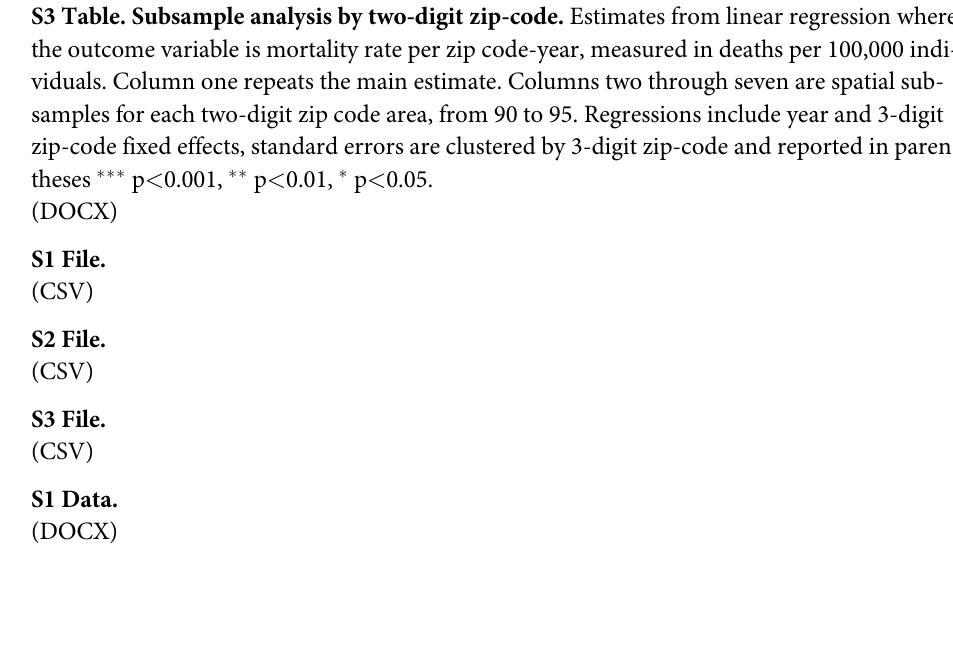
S1 Table. Summary statistics for sociodemographics and pollution burden. Data for 551 California zip codes in Heart Disease sample matched with socioeconomic data from 2010 Census, 2012–2016 American Community Survey, 2000 Decennial Census, and Longitudinal Employer-Household Dynamics (LEHD), and CalEnviroScreen 3.0. S2 Table. Spatial auto-regression model for each year. Estimates from a linear regression with spatially correlated error terms estimated using the spregress command (McMillan et al. 2008). Each column corresponds to a year of data. Coefficients reported are for the total effect of the Shannon index on mortality. Panel A is Heart Disease mortality and panel B is Stroke mortality. Estimates from 2018 also reported in main text. ��� p < 0.001, �� p < 0.01,